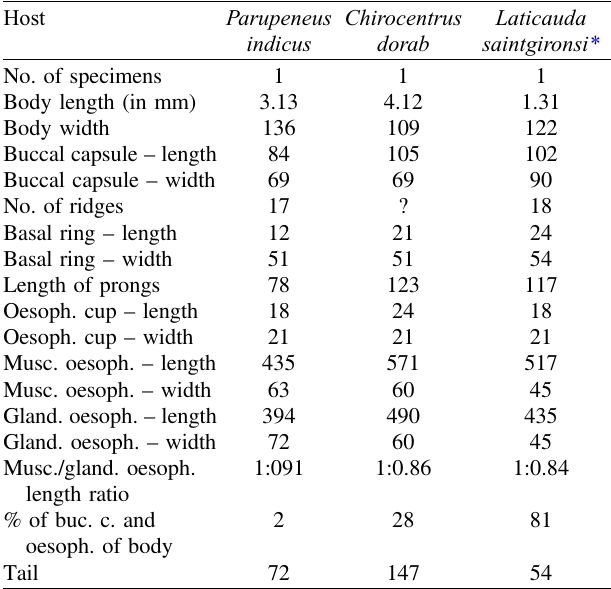
Table 3. Comparison of measurements of Camallanus carangis four-stage larvae from fi sh and reptilian hosts in New